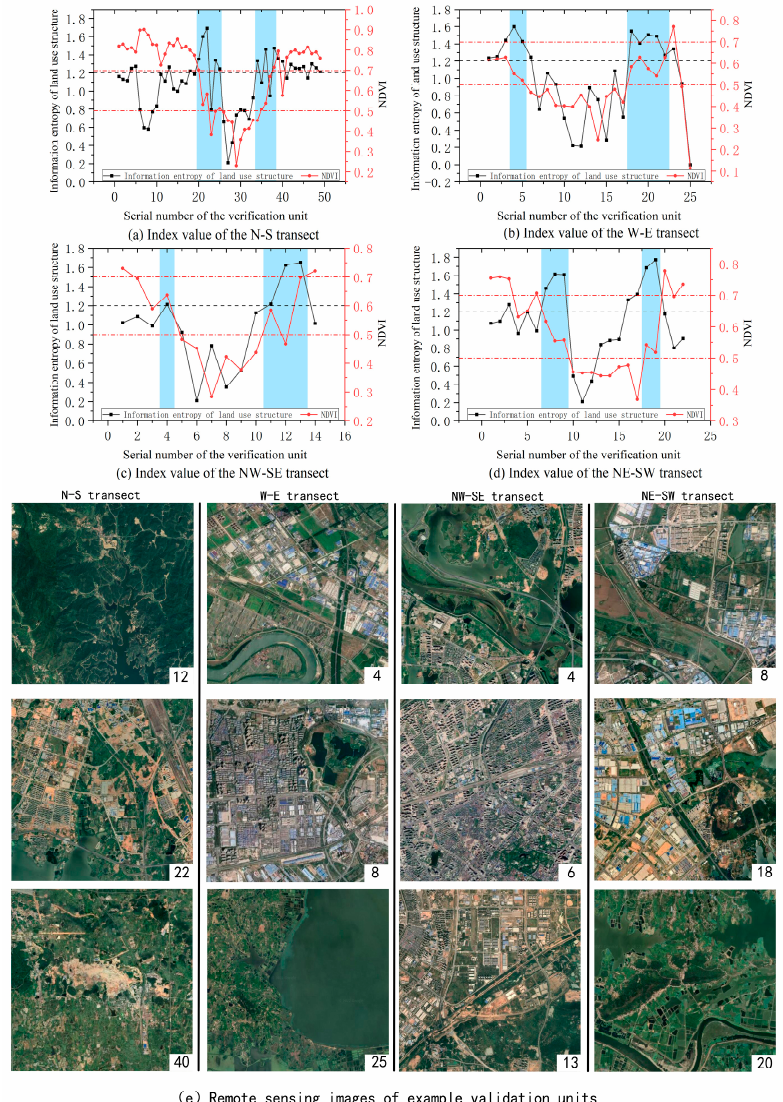
Figure 9. Analysis results of Verification transects.